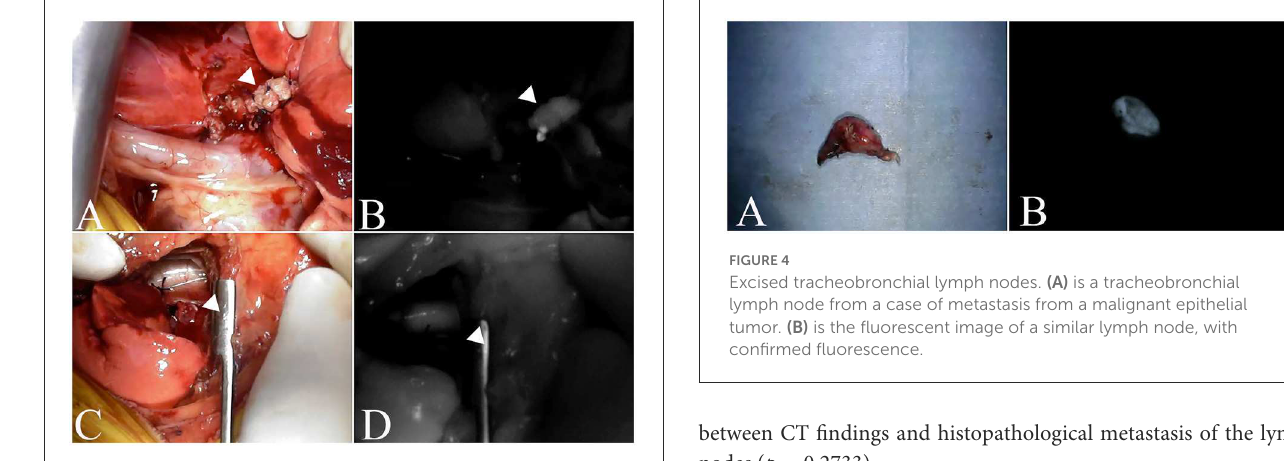
FIGURE3 Fluorescence of the excised margin after excision of the tumor. The arrowhead indicates resection margins. (A, C) are the resection margins of lung adenocarcinoma, and (B, D) are fluorescence images of the resection margins of the same case. (A, B) is an incomplete resection where fluorescence is observed, whereas (C, D) is a complete resection and no fluorescence is observed.